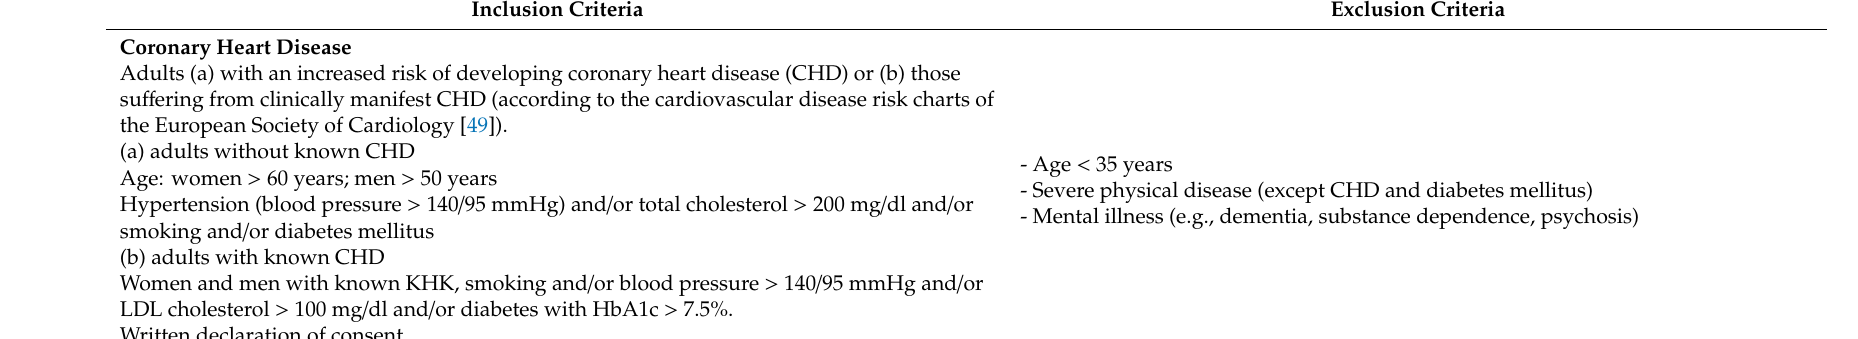
Table A2. Inclusion and exclusion criteria in four clinical